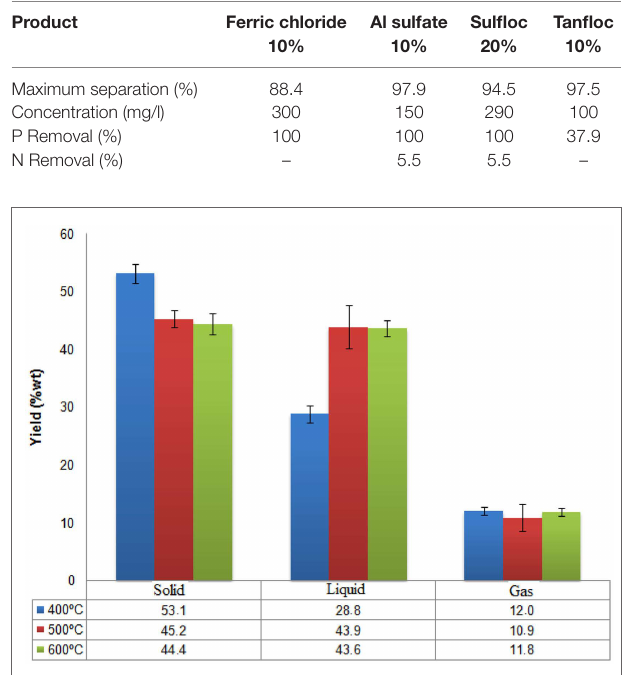
FigUre 4 | influence of temperature on pyrolysis products .